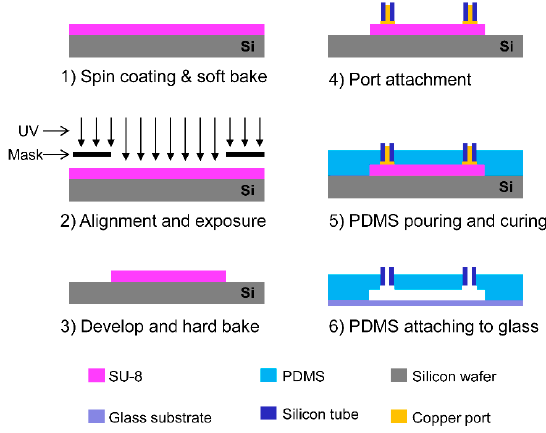
Figure 13. Steps in the fabrication of the microfluidic device.